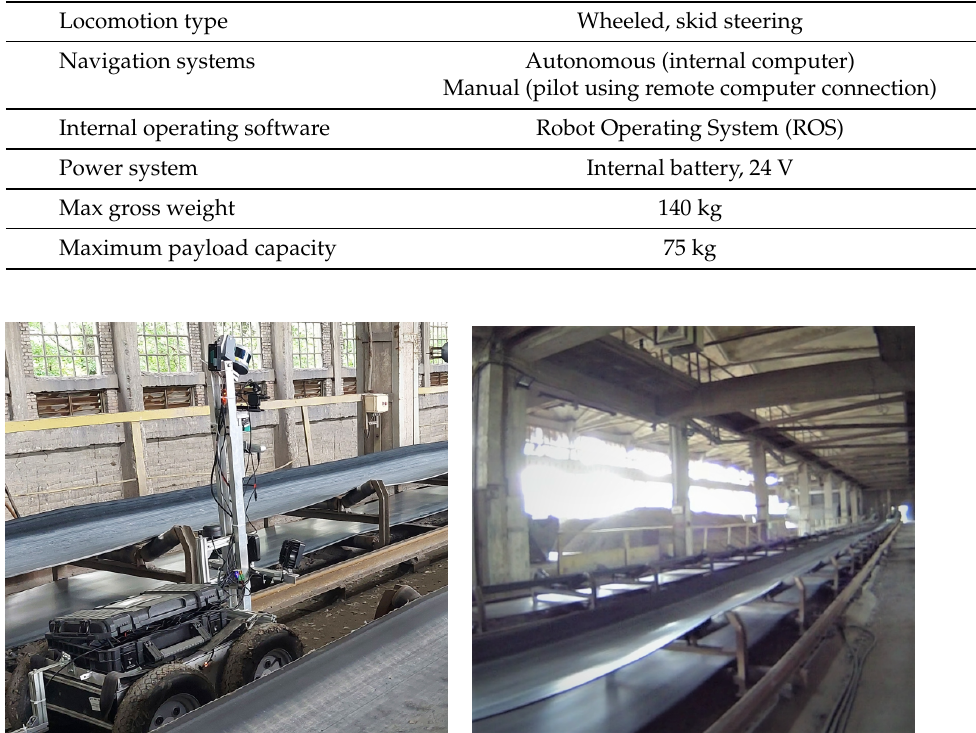
Table 2. The main characteristics of the mobile inspection robot.